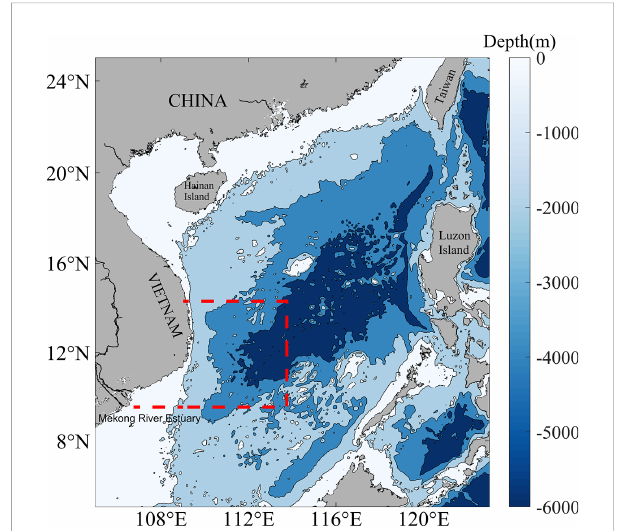
FIGURE 1 Bathymetry (m) of the SCS region. The red dashed box is the study area. The bathymetry data is obtained from